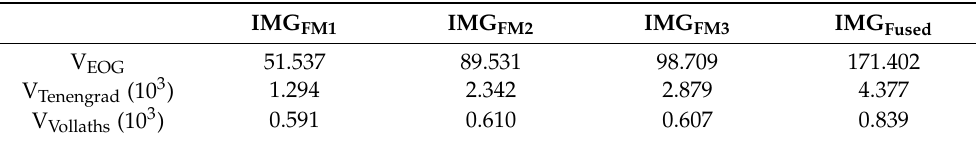
Table 7. Objective evaluation results 1 of image clarity.